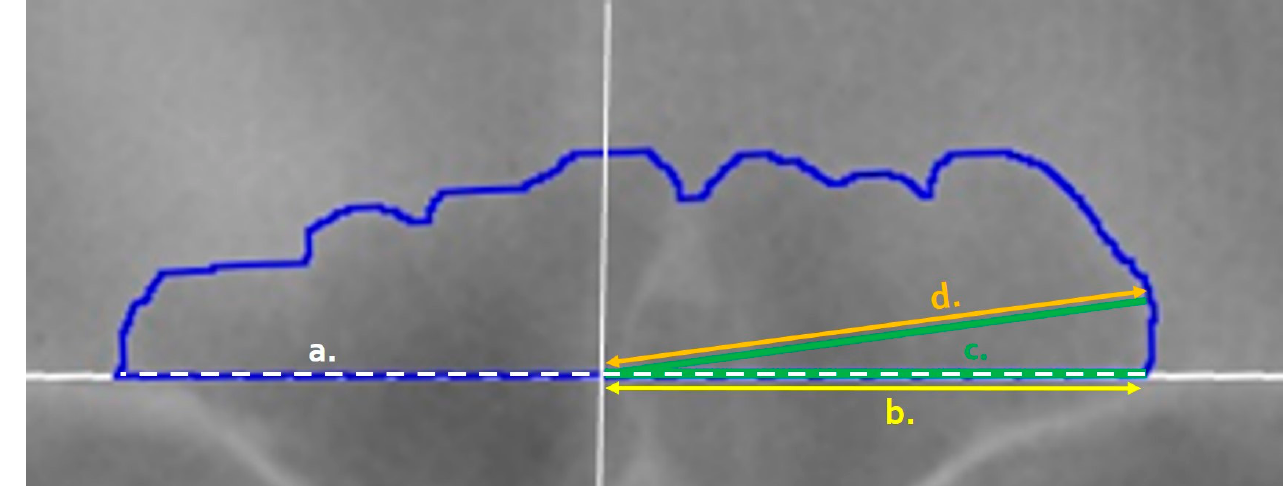
Figure 3. Variables of the frontal sinus as recorded in ImageJ: ( a ) Baseline Length (white dashed line) captures the sinus outline base; ( b ) Right Baseline Length (yellow, offset) captures the right-side of the image baseline from the origin (marked by a solid white vertical line); ( c ) the Angle Perimeter (green) is drawn from the right side of the image baseline to the origin (fixed arm, dashed) and to the inner contour of the blue sinus outline along the specified degree (movable arm, solid green); and ( d ) the Line Length (orange) is calculated via the subtraction of the right baseline length (yellow) from the angle perimeter length (green).